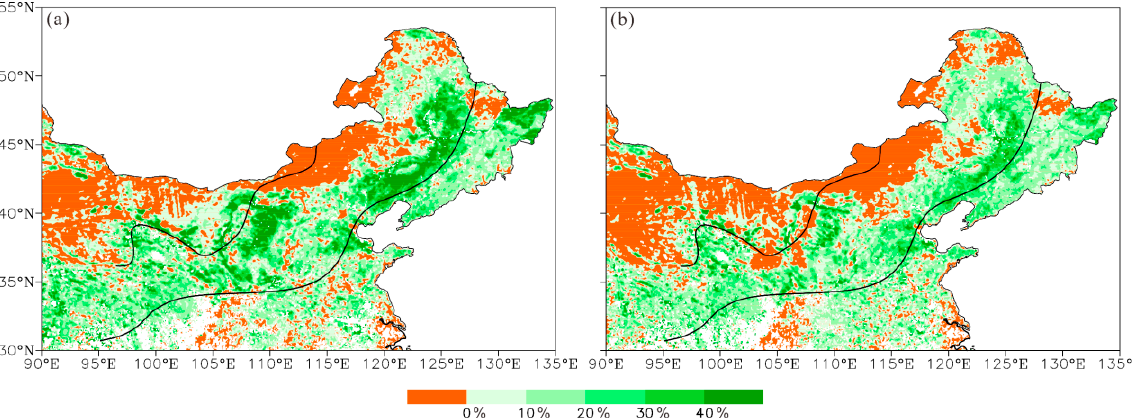
Figure 5. The greening (increase in LAI) of NDPB for 2001–2011 relative to 1982–1990 ( a ) and 1991–2000 ( b ).